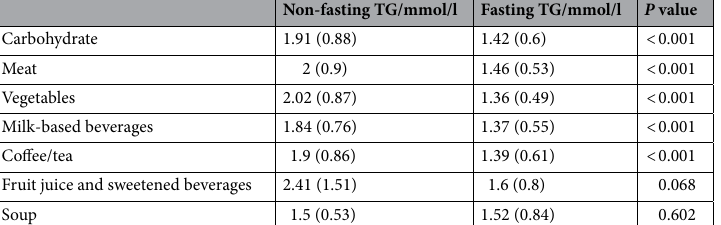
Table 5. Association of non-fasting TG and food items consumed using independent t-test. Carbohydrate includes: bread/buns/biscuits/crackers, rice/porridge/potatoes/carrot cake, noodles/Kway Teow,